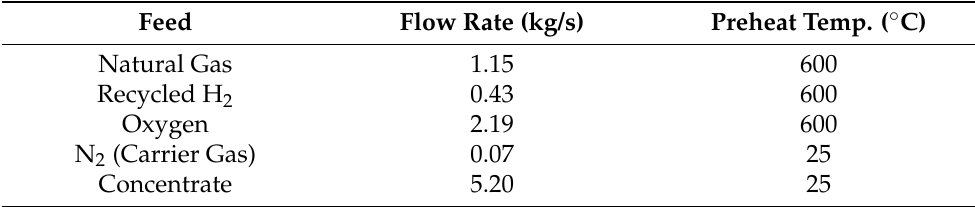
Table 5. Operating conditions for solid product with input gases preheated to 600 ◦ C.